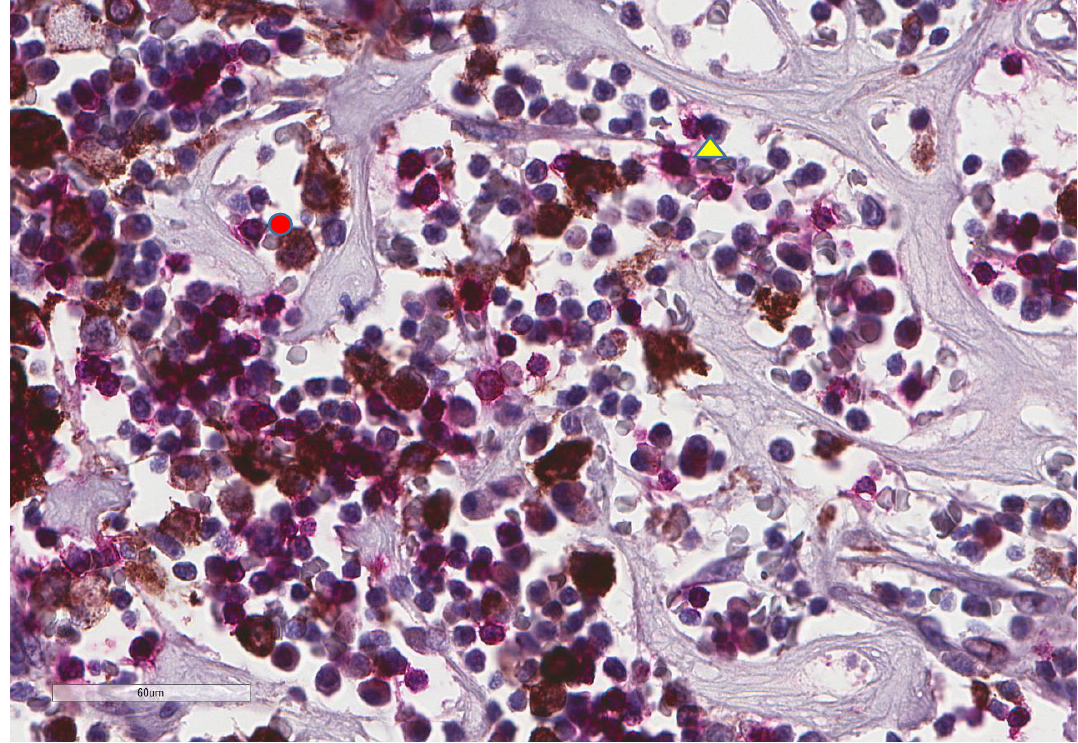
Figure 11. Representative microscopic image of a double stain for PD-L1 (DAB = brown) and CD8 (magenta), showing that most CD8 cells (yellow triangle) do not express PD-L1, which is found in larger cells (red circle) (×400 magnification).